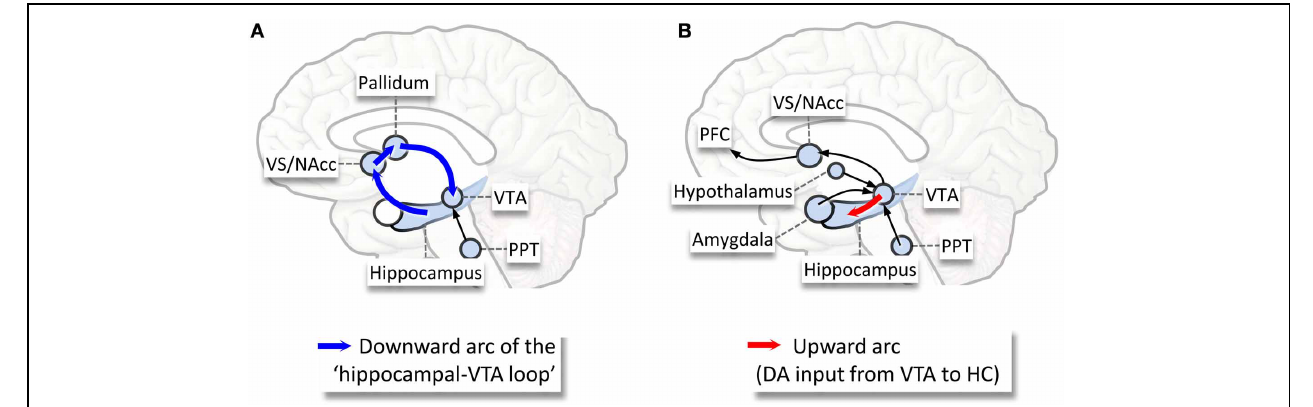
FIGURE 1 | Schematic illustration of the activation of the mesolimbic-dopaminergic reward system during sleep, and the possible functional interactions within this system, as proposed by the Reward Activation Model (RAM) (Perogamvros and Schwartz, 2012). (A) During NREM sleep, the activation between hippocampus and VS allows a spontaneous reactivation (replay) of reward-related neuronal firing patterns in the VS, which would involve a transfer of novelty/relevance signal from the hippocampus to the VTA (blue arrows). VTA would be activated during the transition from a NREM episode to REM sleep, with induction of both tonic (hippocampus–VTA projection) and phasic (PPT–VTA) increase of dopamine. Other emotion- and reward-related structures activated during NREM sleep